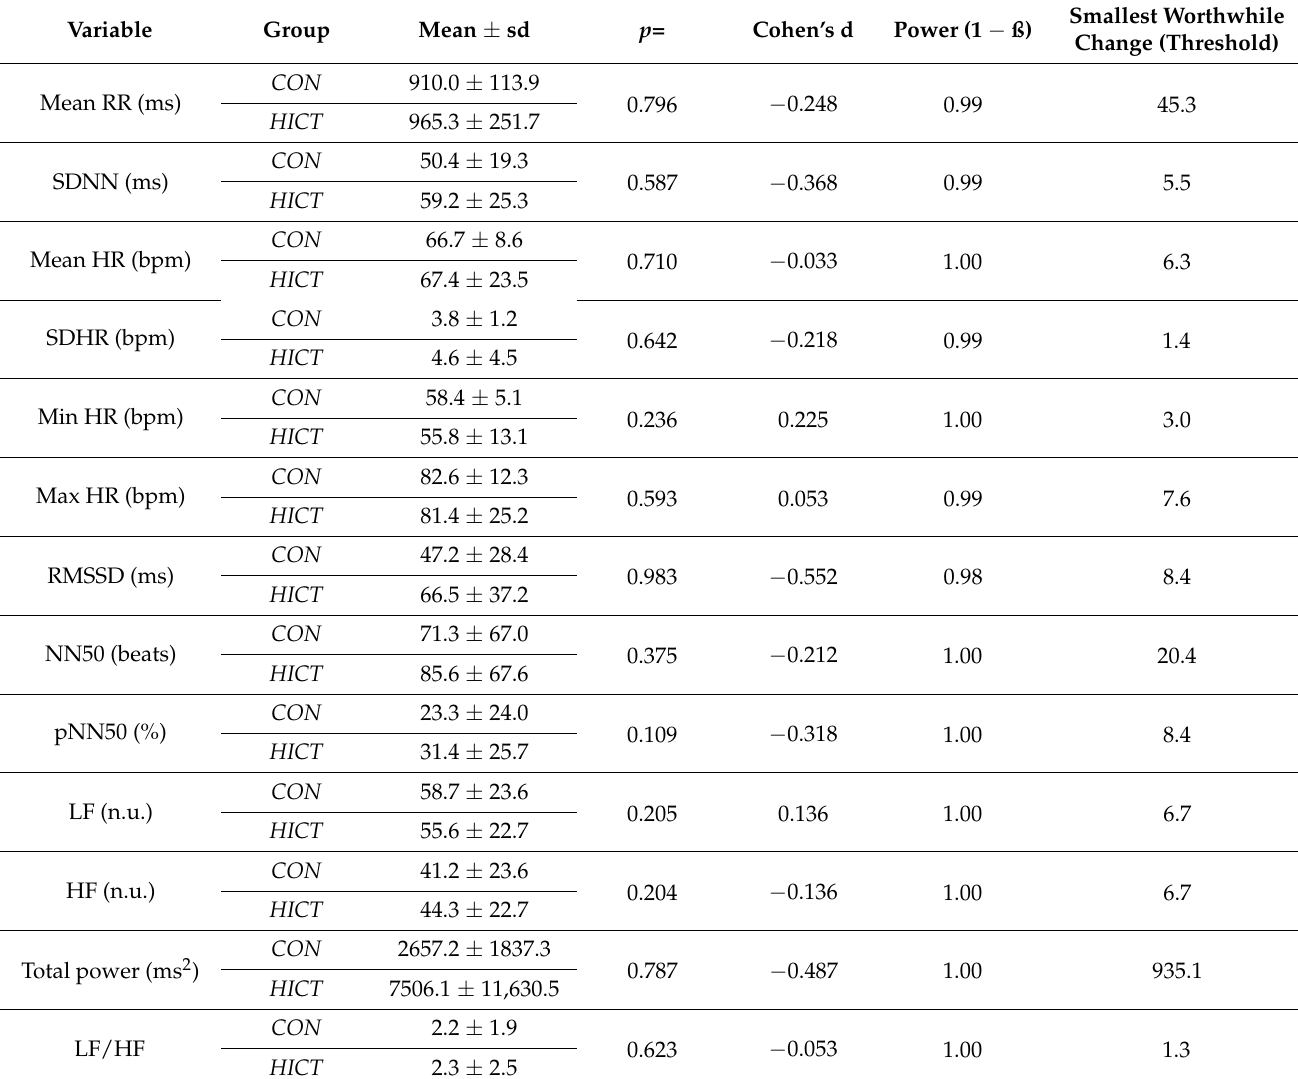
Table 2. Probability and test power for each resting heart rate variability parameter. Under the analysis of covariance relevant difference.